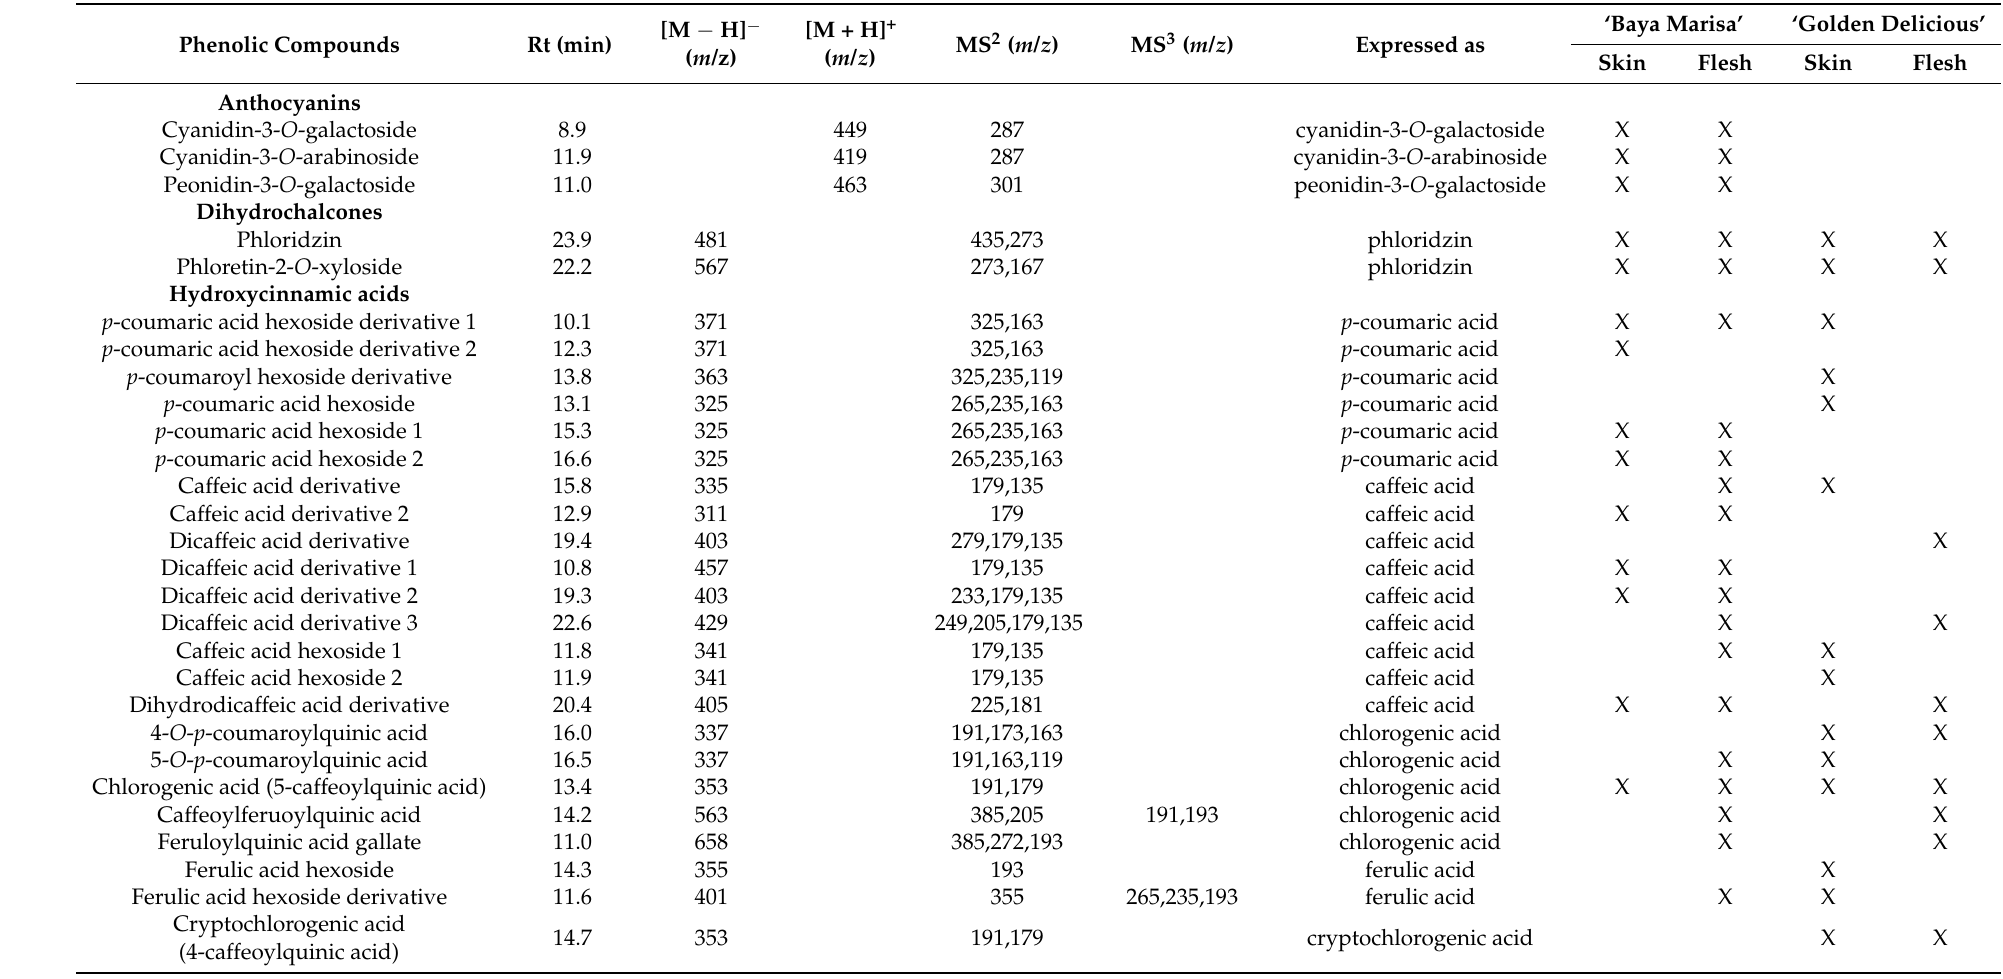
Table 2. Tentative identification of the 47 phenolic compounds of Malus domestica Borkh. cultivars ‘Baya Marisa’ and ‘Golden Delicious’ and used standards. Phenolic